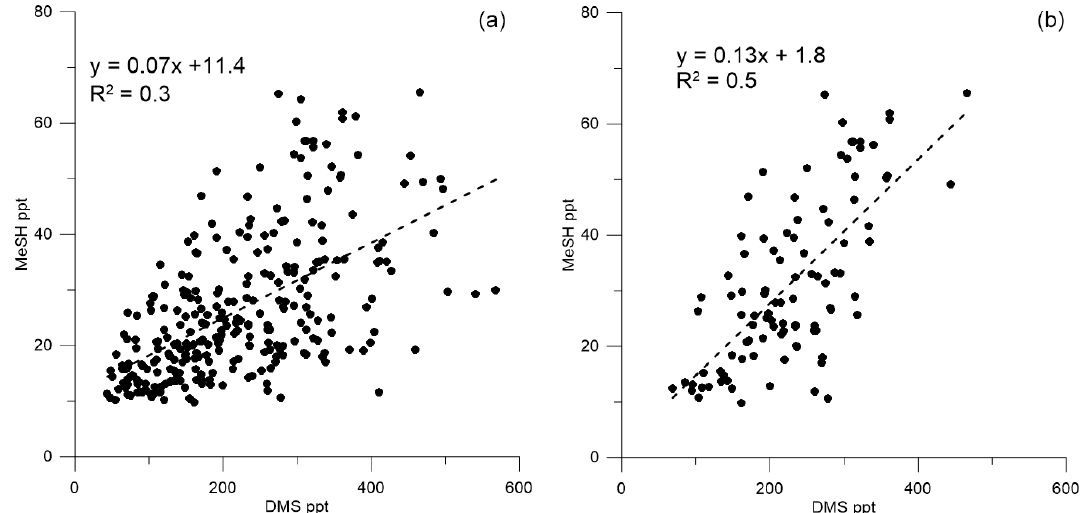
Figure 5. Correlation between (a) DMS a and MeSH a all data (DOY 49 onwards) and (b) DMS a and MeSH a bloom (B2) only.